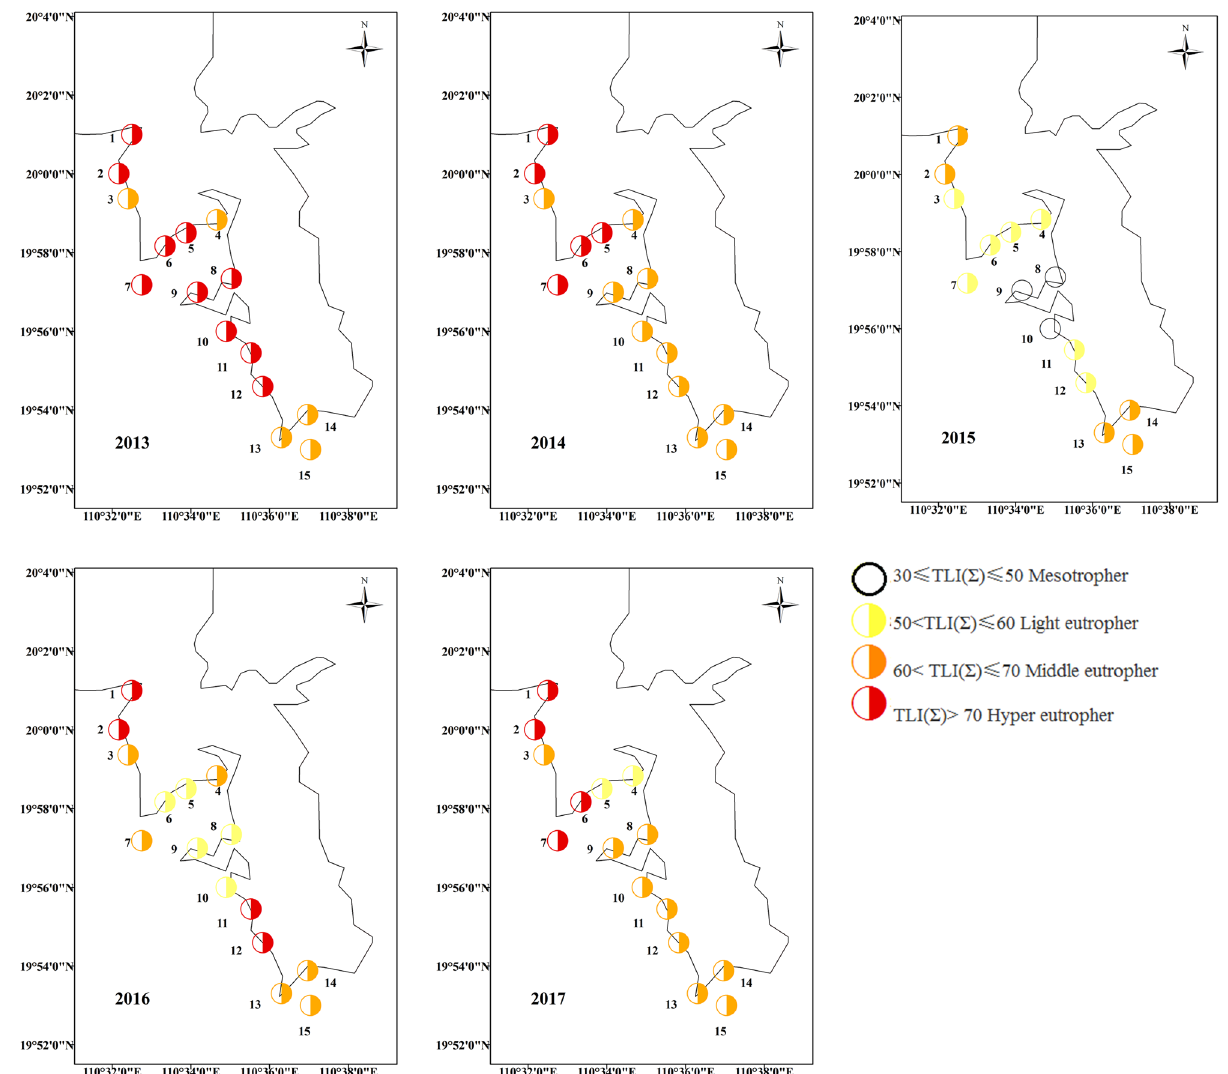
Fig. 6 Trophic level index for each sampling point along Dongzhai harbor from 2013 to